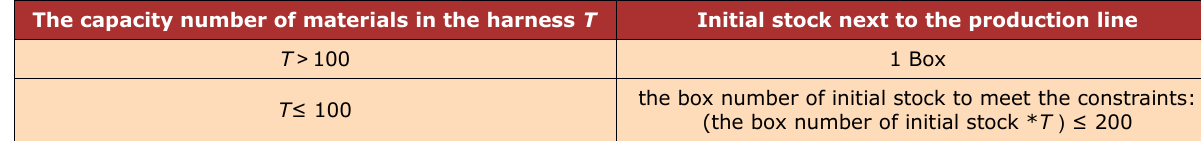
Table 7. Rules of the Initial stock next to the production